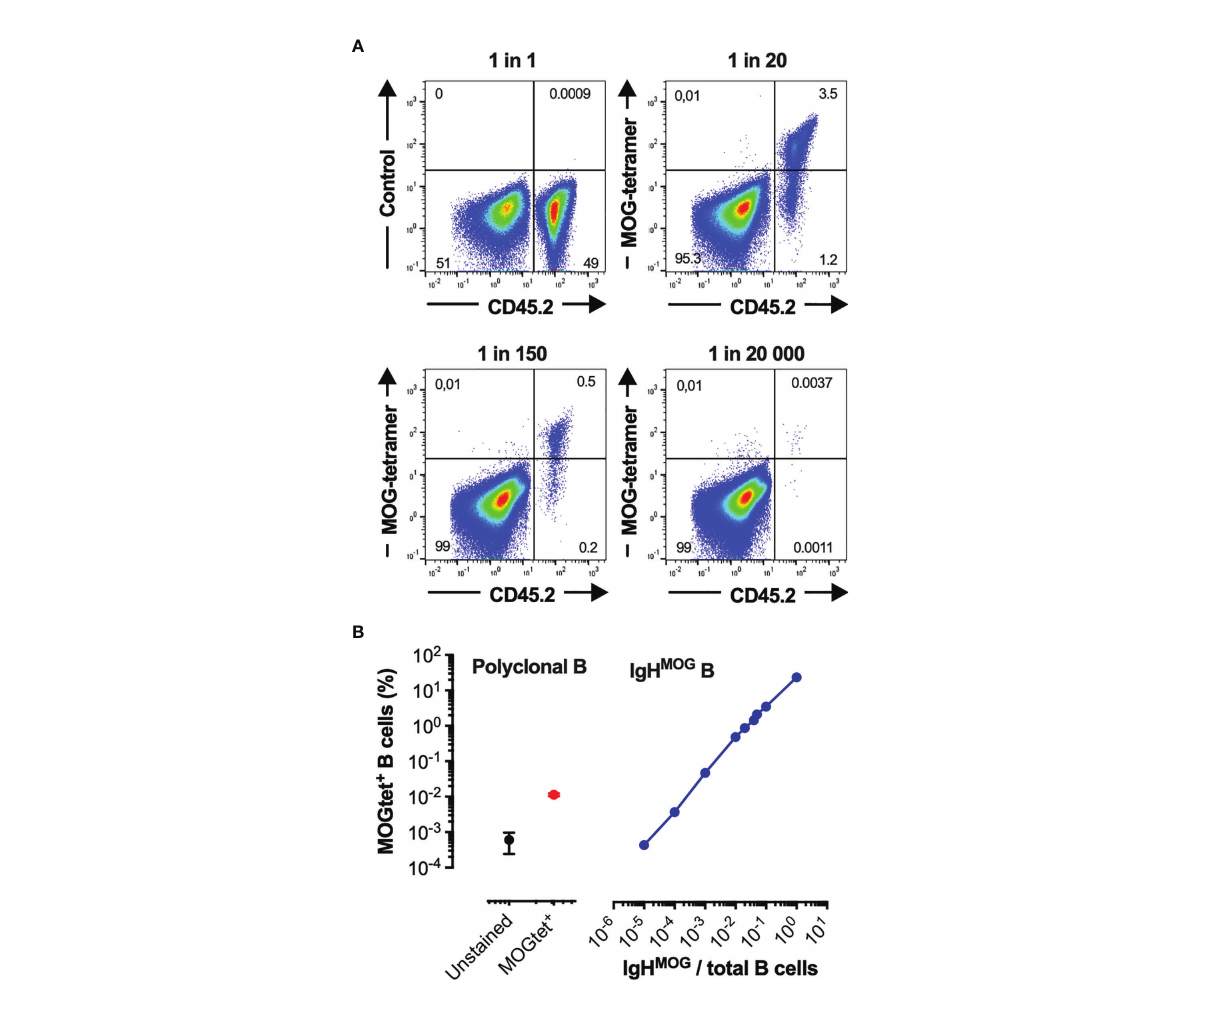
FIGURE 4 | Validation and sensitivity of the recombinant MOG 1-125 -tetramer. (A, B) Puri fi ed CD45.2 +/+ B cells from homozygous C57Bl/6 IgH MOG mice were mixed in vitro with puri fi ed B cells from congenic CD45.1 +/+ mice at the indicated ratios. (A) A representative fl ow cytometry pro fi le demonstrating the capacity of Streptavidin-FITC MOG 1-125 -tetramers to identify IgH MOG B cells among polyclonal CD45.1 +/+ B cells (Top right, bottom), the Streptavidin-FITC MOG 1-125 -tetramers were omitted in the control samples (Top left) (B) Sensitivity of the Streptavidin-FITC MOG 1-125 -tetramers in detecting the precursor frequency of the IgH MOG B cells. Left panel, MOG-tet + staining of CD45.1 +/+ polyclonal B cells (red circle), and the control staining without the MOG tet (black circle). Right panel, MOG-tet + staining off CD45.2 +/+ IgH MOG B cells serially diluted among CD45.1 +/+ polyclonal B cells (blue line). The mean +/- SEM is presented from 2 pooled